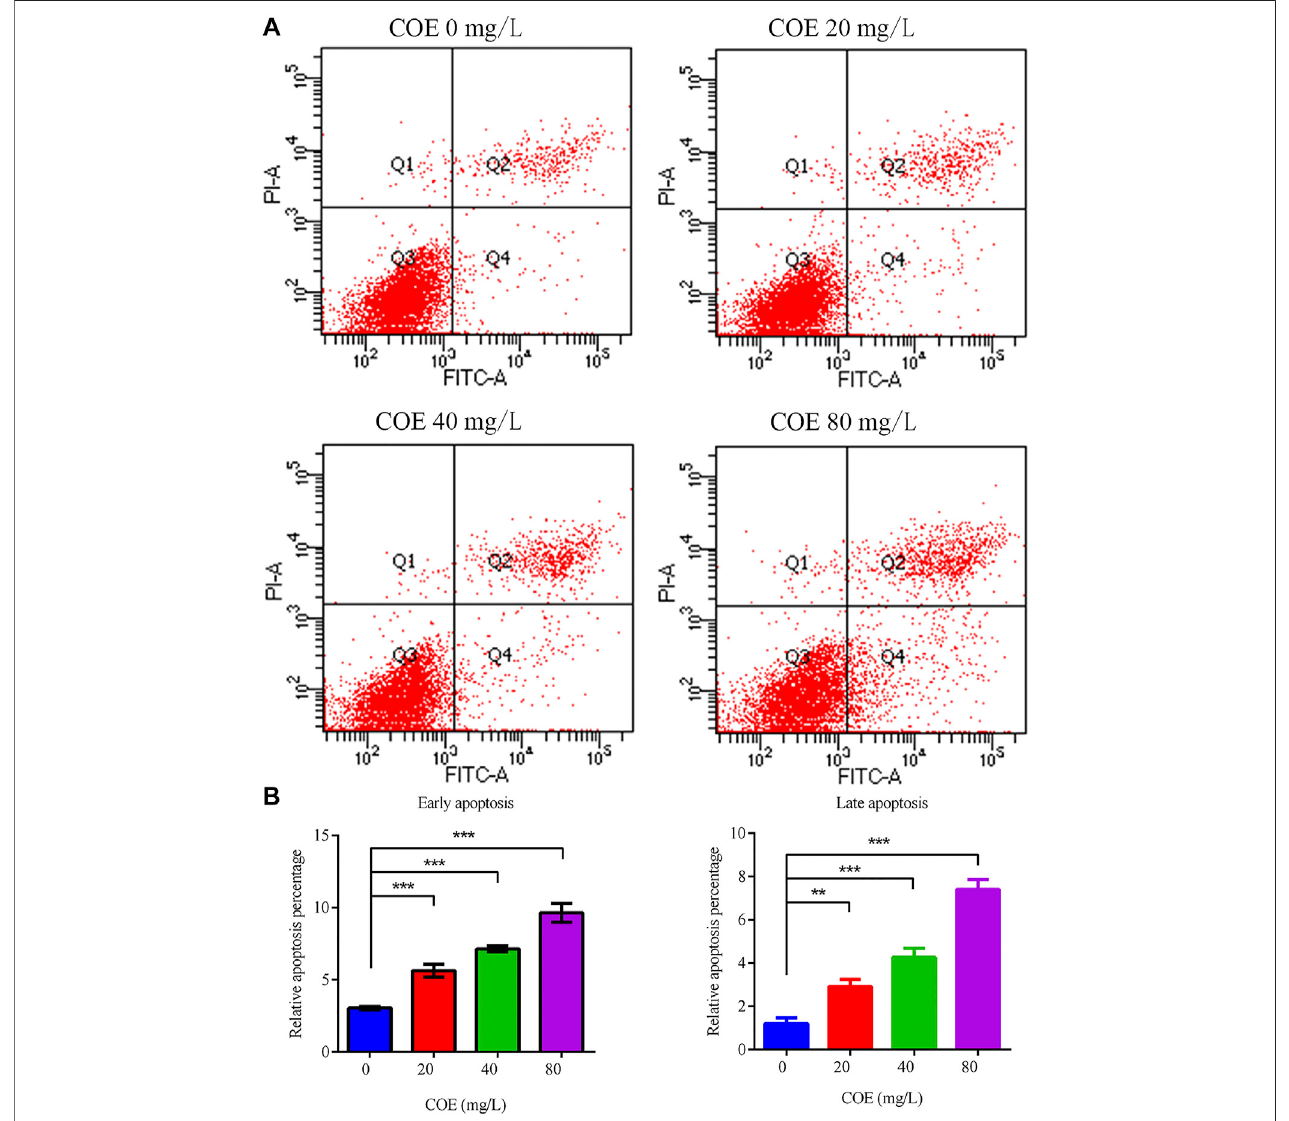
FIGURE 3 | Effect of the ethyl acetate extract of Celastrus orbiculatus (COE) on early and late apoptosis of human gastric cancer AGS cells. (A) and (B) COE can signi fi cantly promote the apoptosis of AGS cells.